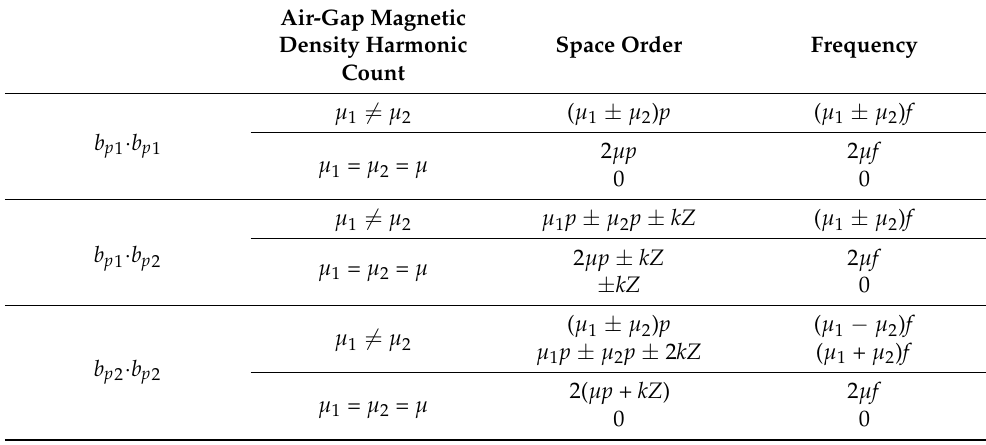
Table 1. Spatial order and frequency distribution of radial electromagnetic forces generated by the action of the rotor’s magnetic field. Air-Gap Magnetic Density Harmonic Space Order Count